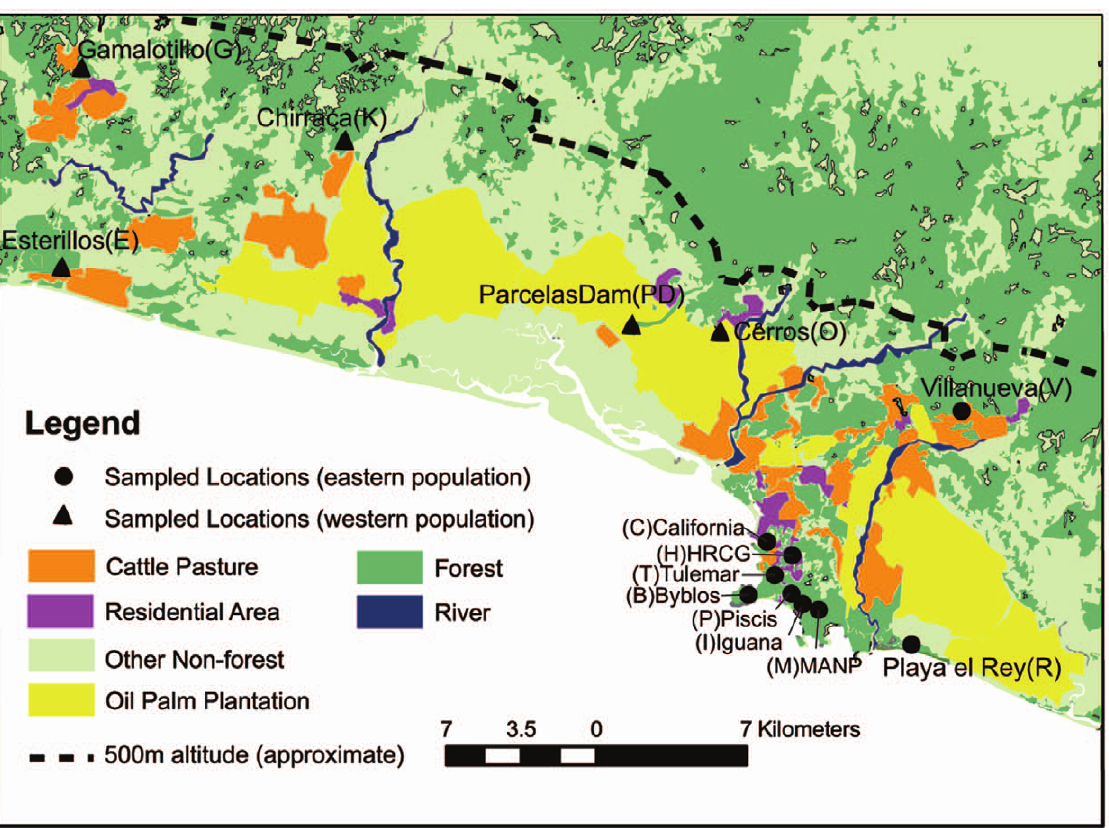
Figure 1. Sampled S.o.citrinellus groups in the Central Pacific region of Costa Rica. Sampled S. o. citrinellus groups in the Central Pacific region of Costa Rica, showing the limit of 500 m asl to their distribution and different classes of matrix habitat as defined by a manual land cover classification.